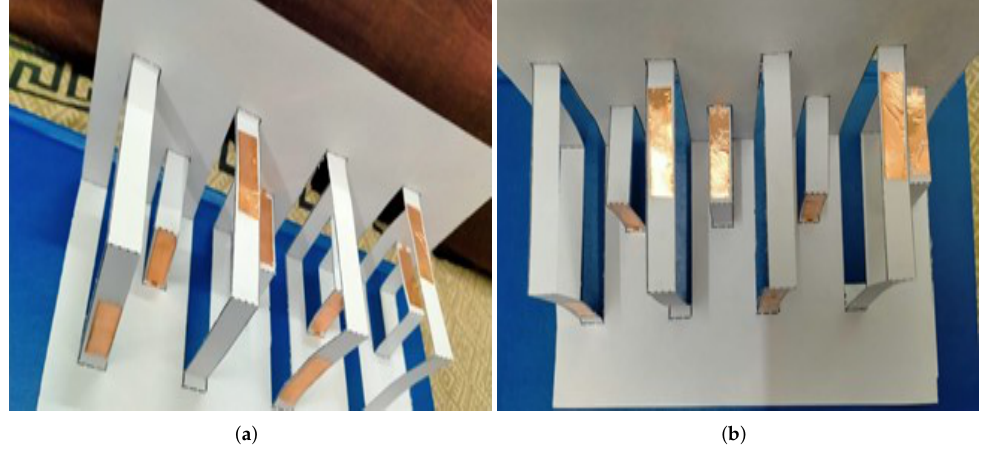
Figure 3. Kirigami MIMO antenna: ( a ) perspective view; ( b ) front